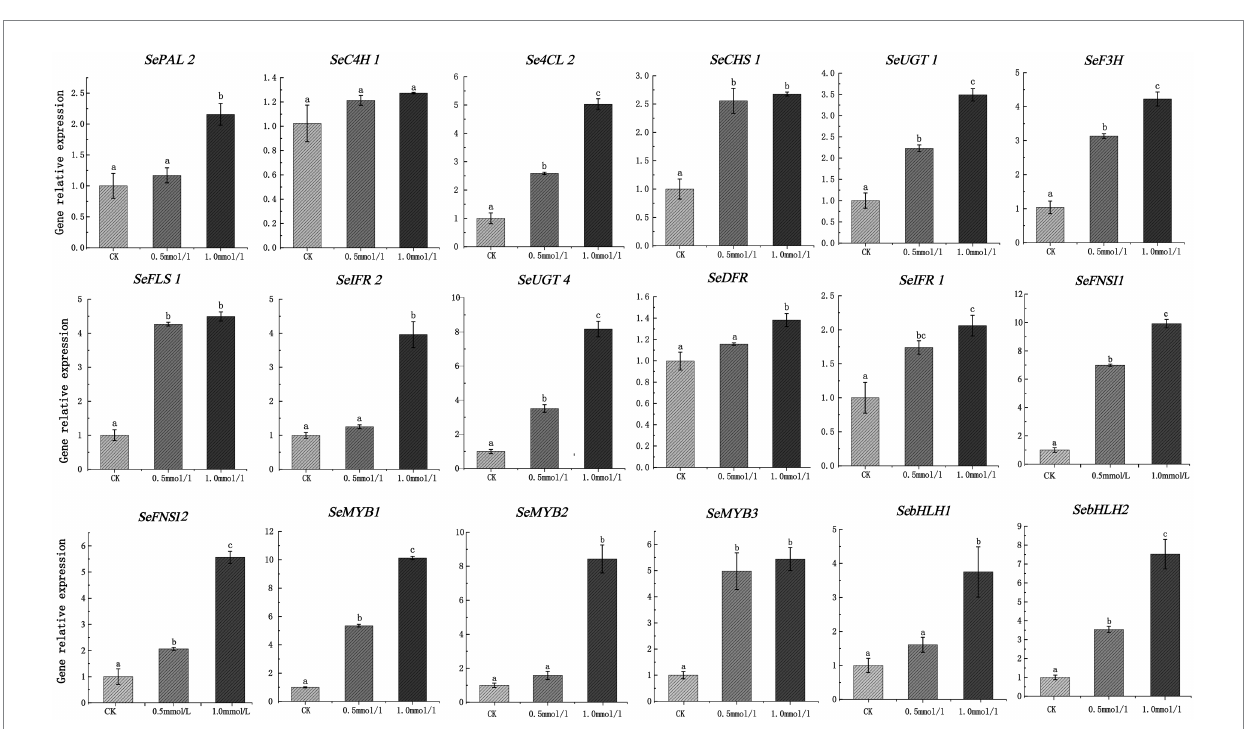
FIGURE 10 Expression profiles of 18 DEGs involved in flavonoid biosynthesis after phenylalanine treatment. The expression levels of DEGs relative to actin7 , measured by qRT-PCR. Three biological replicates and three technical replicates were obtained for each data point. Lower case letters (a, b, c) above the error bars represent significant difference between the treated and untreated (0 g/l) samples ( p <